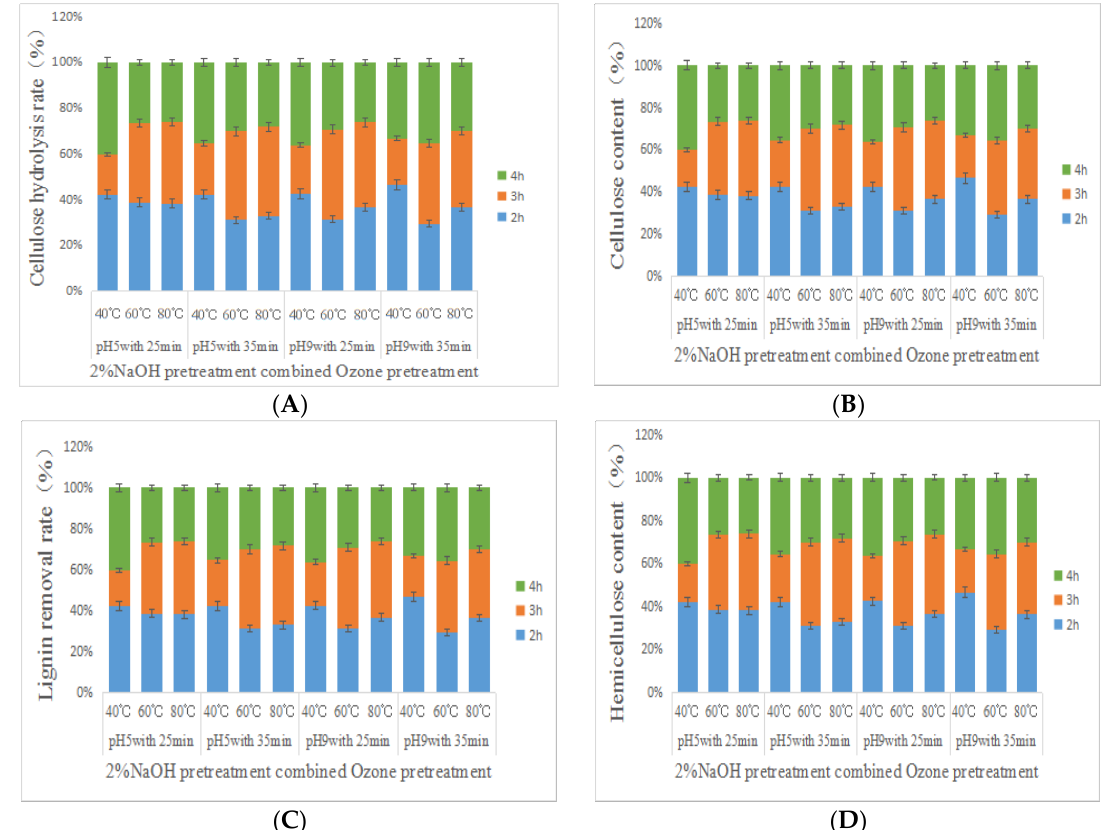
Figure 1. Results of enzymatic hydrolysis and content of cellulose, lignin and hemicellulose in corn stover after NaOH-ozone pretreatment. ( A ) Cellulose hydrolysis rate; ( B ) Cellulose content; ( C ) Lignin removal rate; ( D ) Hemicellulise content.